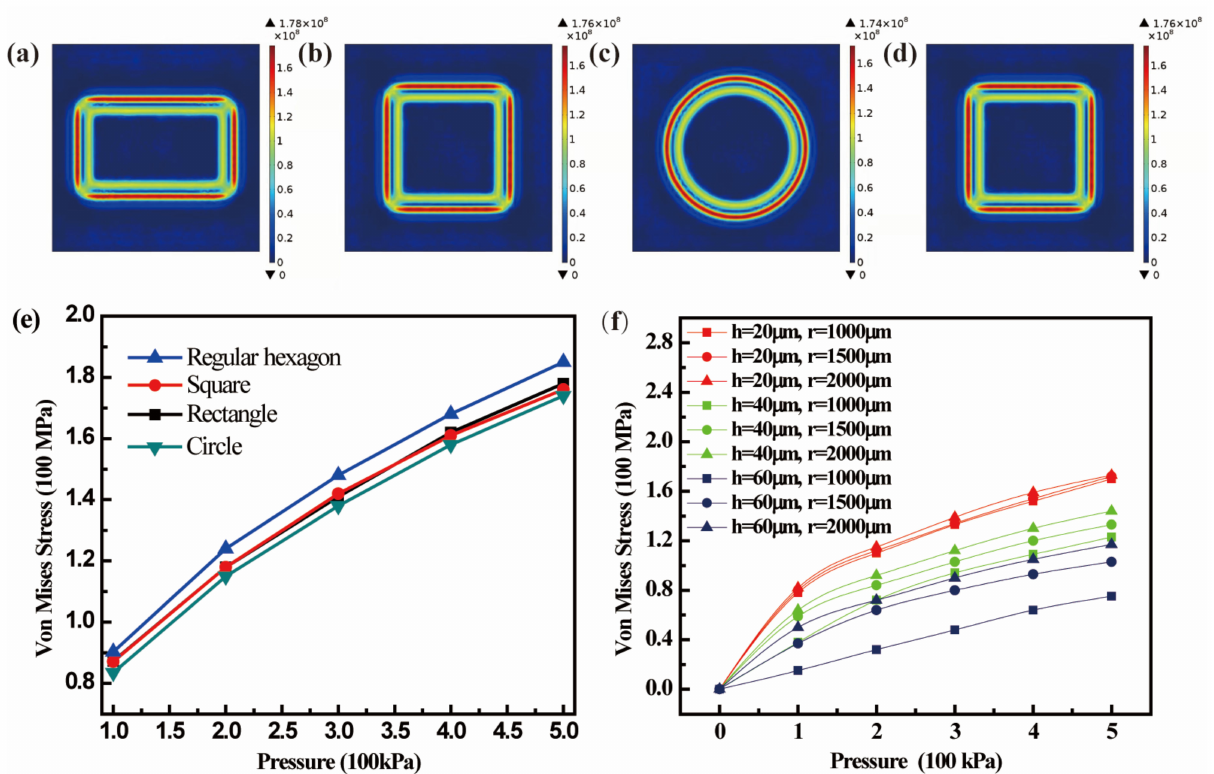
Figure 2. Simulated stress distributions on ( a ) rectangle, ( b ) square, ( c ) circular, and ( d ) regular hexagon diaphragms; ( e ) Simulated S-P curves based on different shapes of Si diaphragms with same area; ( f ) Simulated S-P curves based on circular Si diaphragm with same area and different thickness and